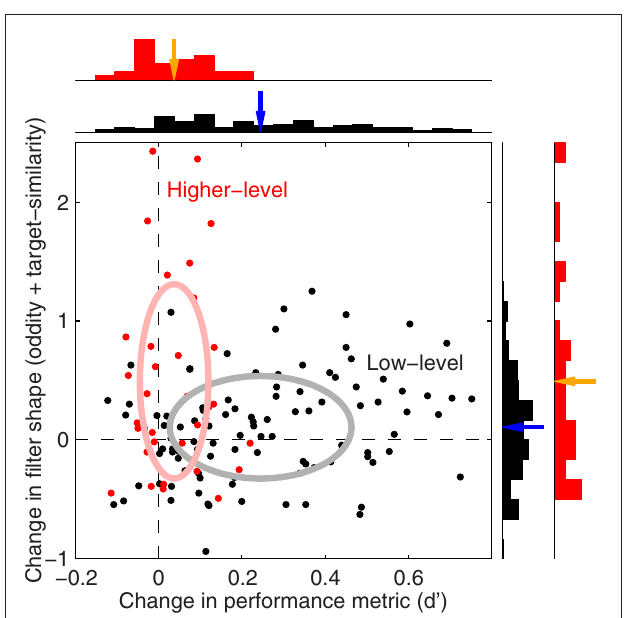
Figure 15 | Low-level manipulations change sensitivity, higher-level manipulations change filter shape. Change in sensitivity (d ′ log-ratio) is plotted on the x axis versus change in filter shape ( y axis) as assessed using an index that combines both oddity and target similarity (see Section 2.7), for both low-level image manipulations (e.g., blob-like transformation) in black and higher-level manipulations (image inversion) in red. See Section 2.7 for details on how different comparisons were classified as low-level or higher-level. Top and right histograms plot distributions; arrows show